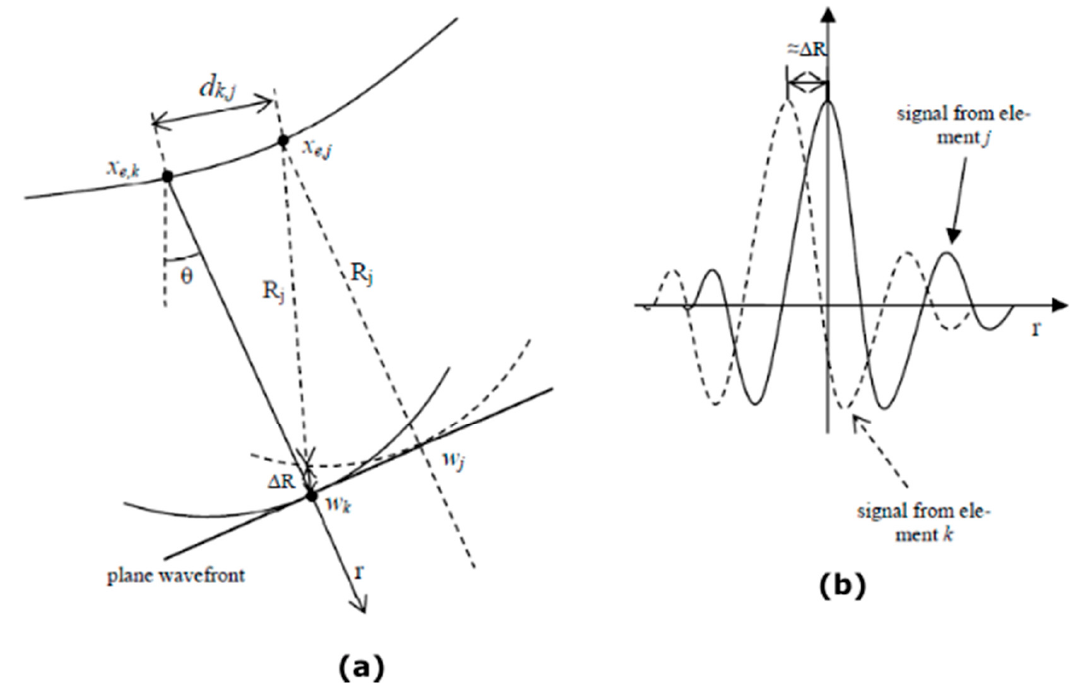
Figure 4. Schematic representation for the estimation of the wavefront amplitude. ( a ) Geometry of the problem and ( b ) Contribution of each element to the plane wavefield.